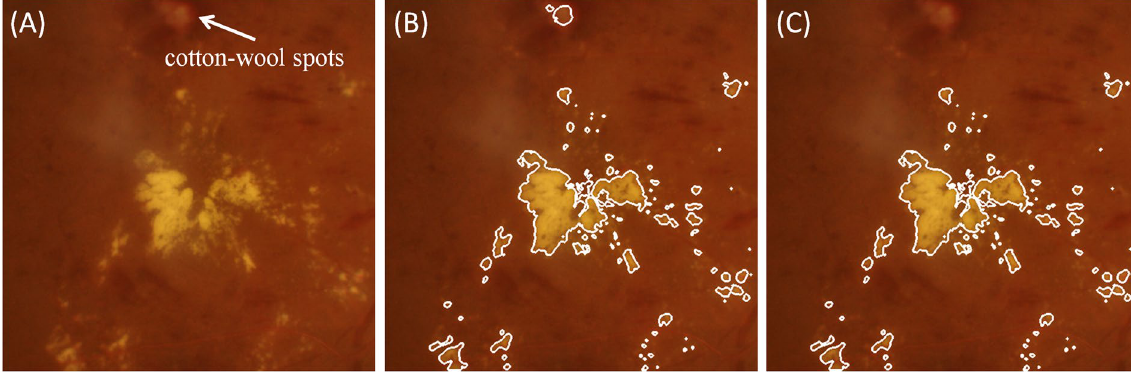
Figure 3. Example of hard exudates segmentation. ( A ) The cropped CFP image. ( B ) Automatic segmentation is superposed on the cropped CFP image, where the white line represents the outline of the hard exudates. ( C ) The corrected segmentation of hard exudates.